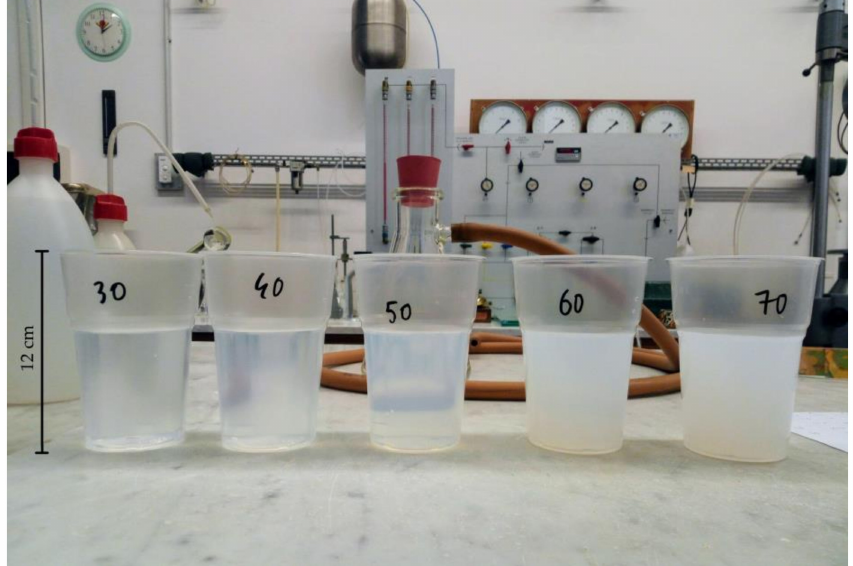
Figure 3. Colloidal silica mixtures (5% CS content) prepared at different ratios of activator to the volume of grout, ranging from 30% to 70% ( ≈ 10 min after